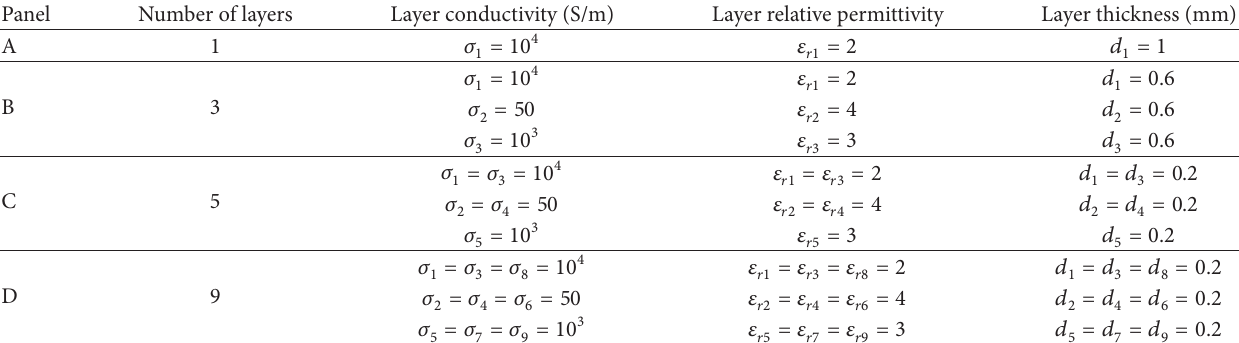
Table 1: Composition of multilayered panels